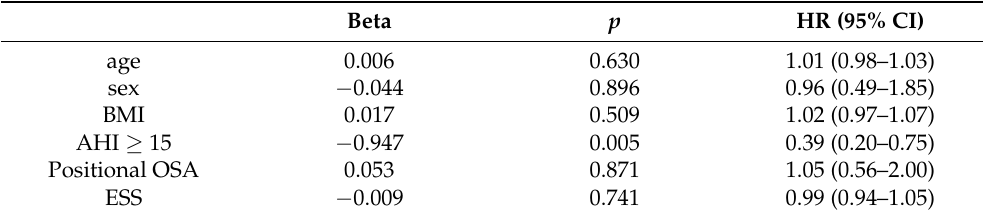
Table 5. Proportional regression of Cox’s